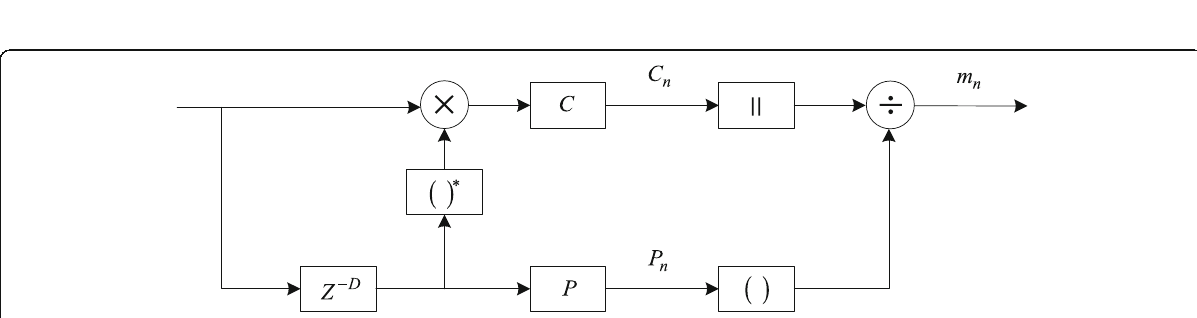
Fig. 4 Circuit procedure for group detection. Group detection is performed by using the leading structure. C n is the mutual correlation between the currently received L data and the L data received before D . P n is the value of received signal energy. m n is the decision variable of the delay correlation